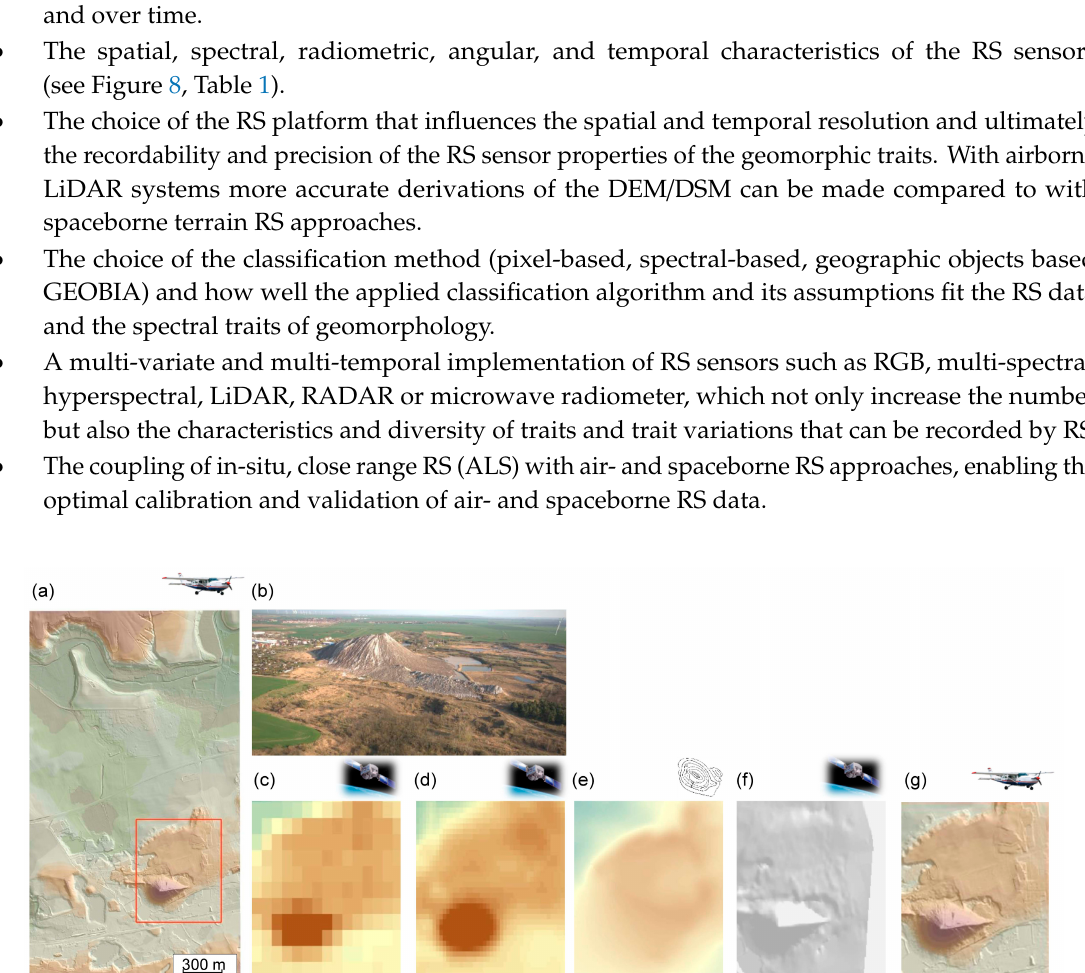
Table 1. Semantic categorization of potentials and practicality of RS platforms and RS techniques for elevation data acquisition; inspired by Mulder et al., [136]: −− = no, − = low, + = medium and ++ = high agreement.